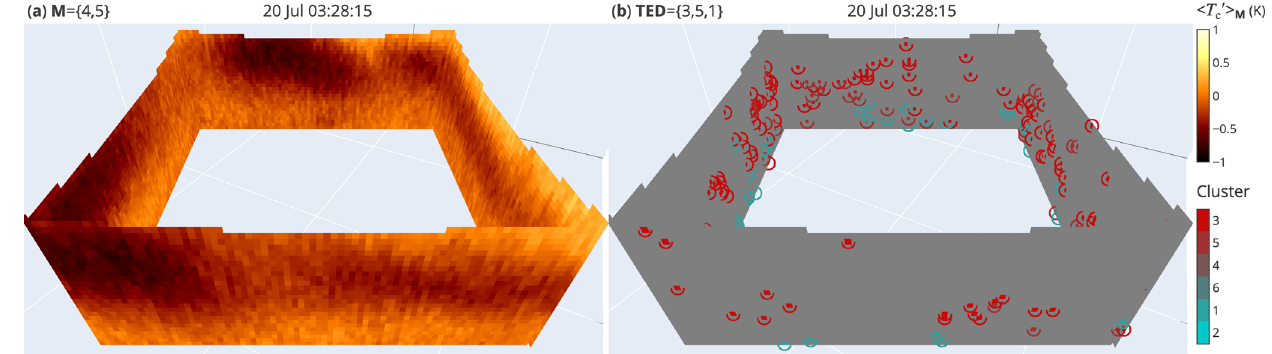
Figure 12. Shown for a nighttime instance are (a) the variance for selected MRD levels ( M ) of T c and (b) the dominant clusters corresponding to detected events within a 45s window. See text for